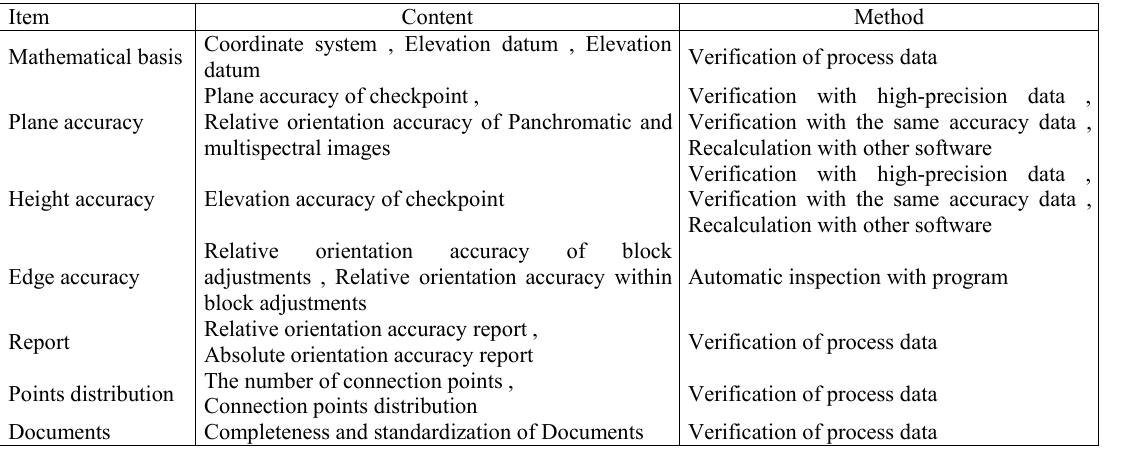
Table 1. Inspection contents and methods